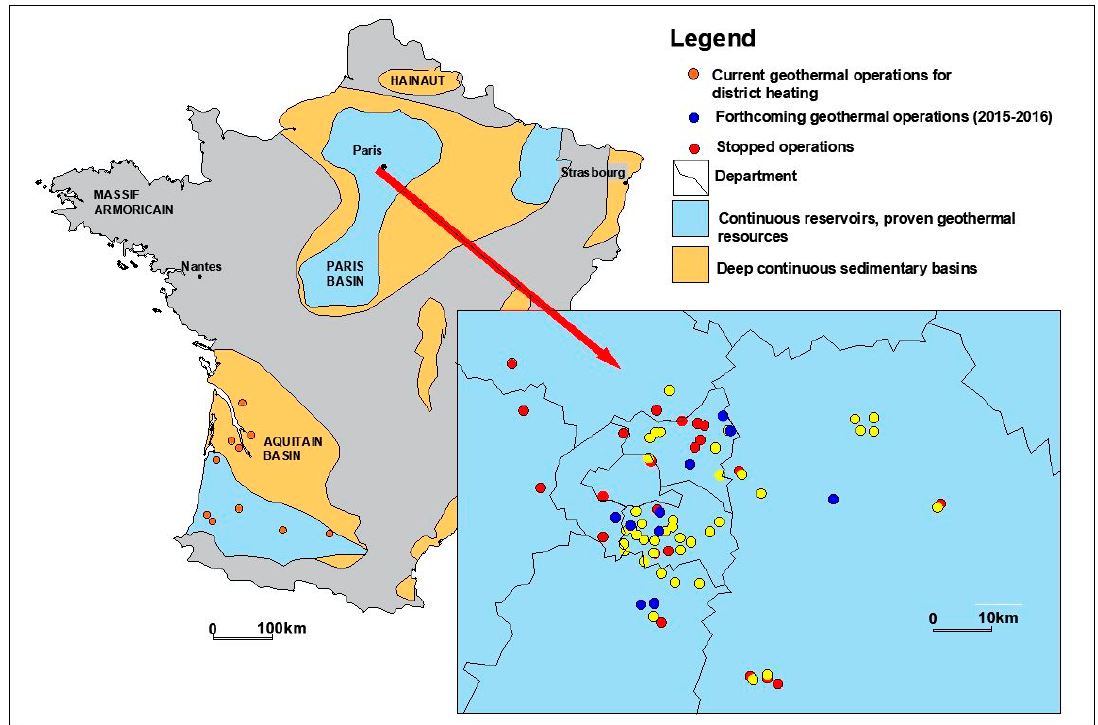
Figure 3. The map of locations of deep geothermal operations (for district heating) within two main sedimentary basins in France (zoom in Ile-de-France) based on [45].